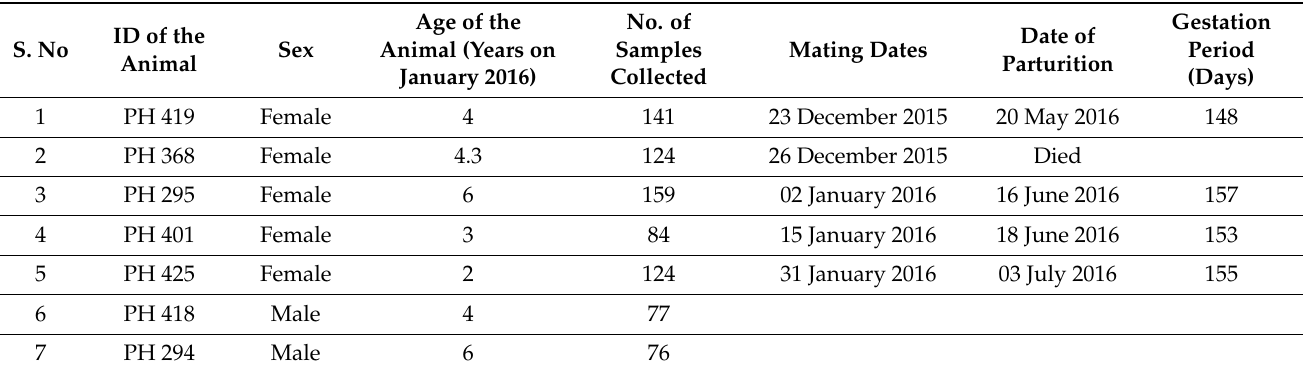
Table 1. Details of the animals studied, samples collected, mating, parturition, and gestation period of pygmy hogs at the Pygmy Hog Research and Breeding Center, Guwahati,